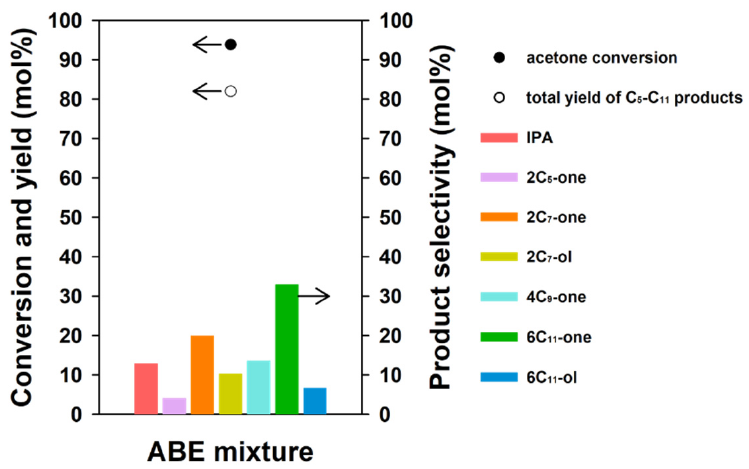
Figure 12. Catalytic performance of 5 wt % Cu/Pr 2 Zr 2 O 7 in the cross-coupling of the ABE mixture. Reaction conditions: 20 g reactant with the acetone/butanol/ethanol mole ratio of 2.3:3.7:1, catalyst 2 g, 240 °C, and 24 h.